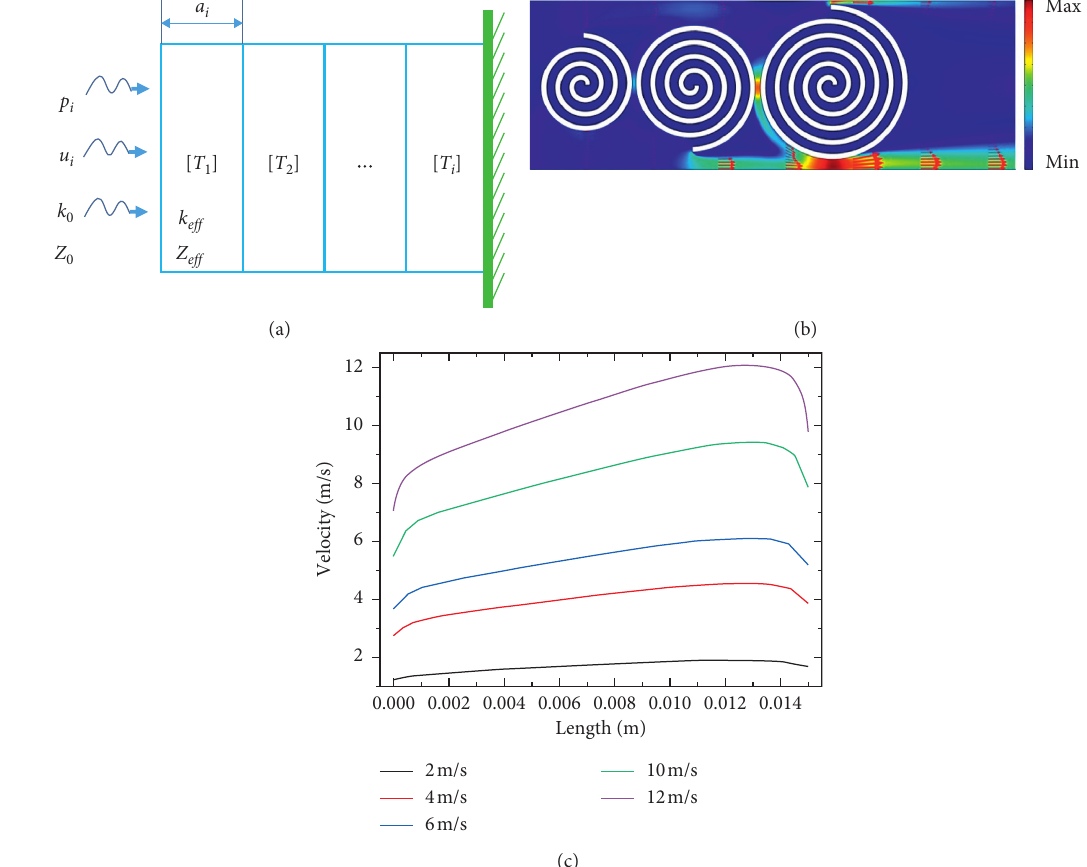
Figure 4: (a) Details of the integrated transfer matrix method. (b) The airflow velocity field of the “9.75–22mm” varied-unit array. (c) The velocity profile along the channel